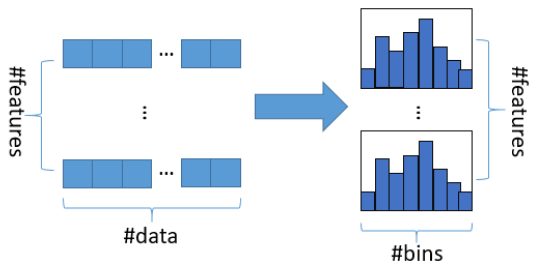
Figure 1. Schematic diagram of the histogram algorithm .